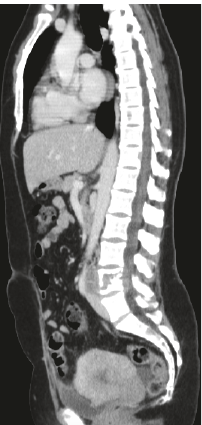
Figure4:Contrast-enhancedCT.Sagittalview.Thereisalyticlesion occupying the L4 vertebral body displaying a soft tissue component. The uterus is enlarged and depicts a nodular and lobulated contour, due to the presence of several leiomyomas.